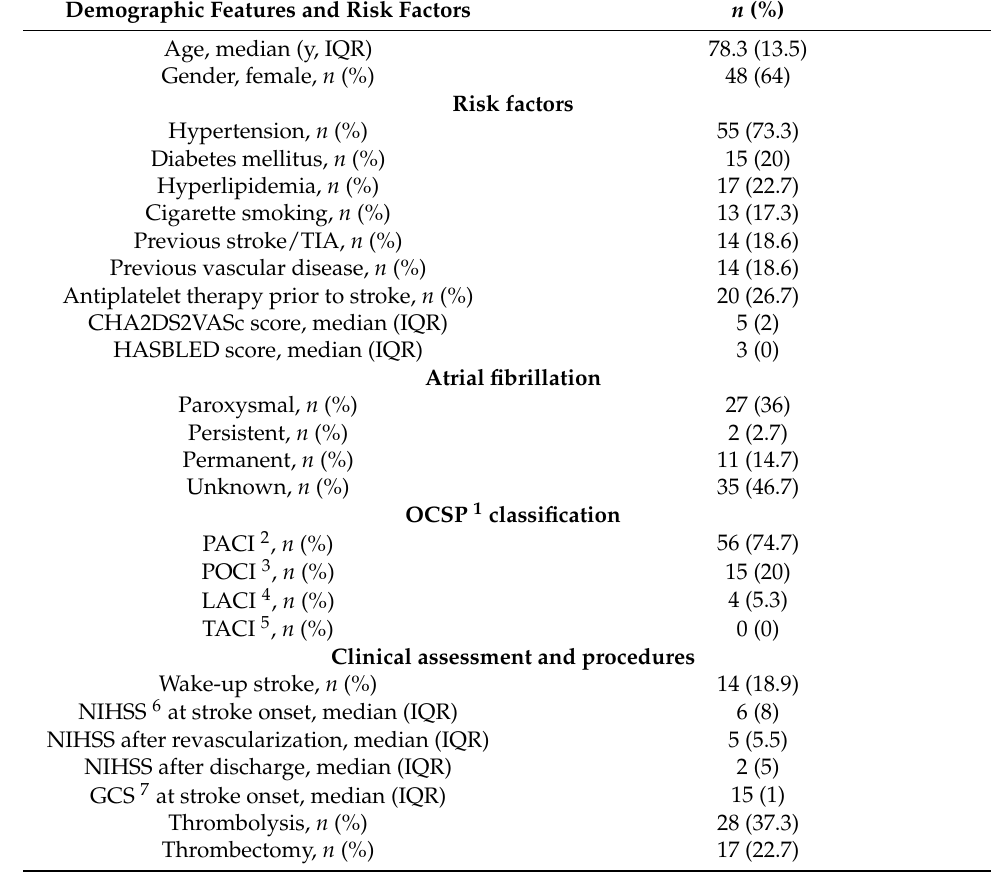
Table 1. Demographic features, risk factors, stroke classification, clinical assessment, and procedures of patients included in the study.